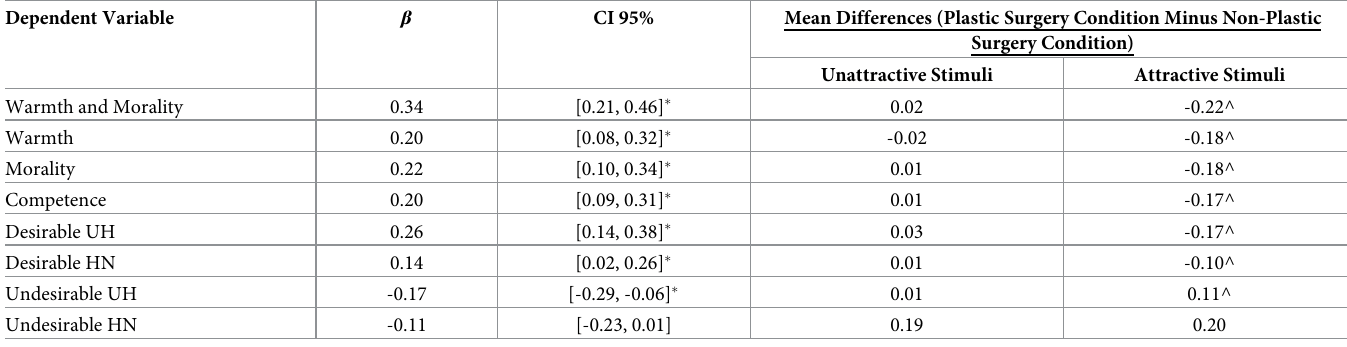
Table 3. The Combined effect of plastic surgery status and attractiveness on person